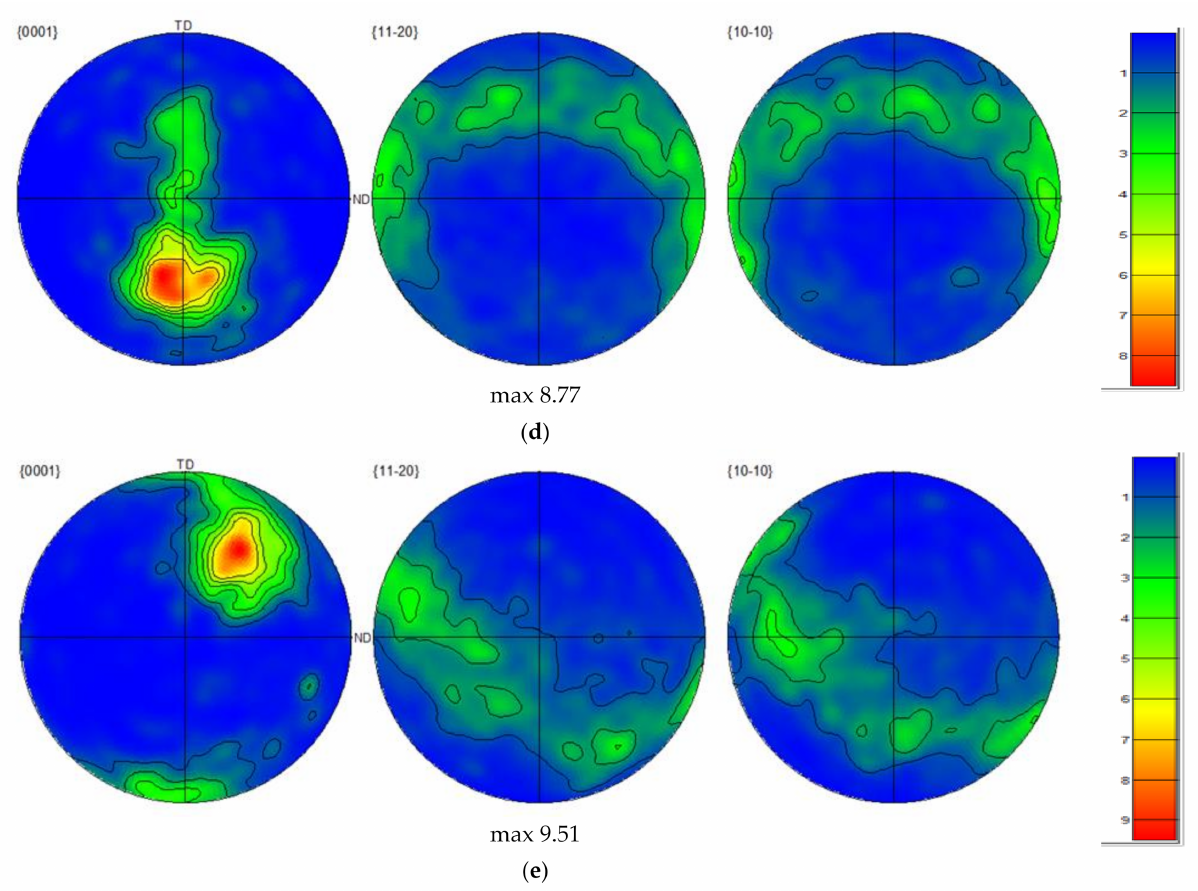
Figure 6. {0001}, {11-20}, and {10-10} pole figures showing the crystallographic texture of ( a ) AA, ( b ) 1-P, ( c ) 4-Bc, ( d ) 4-A, and ( e )